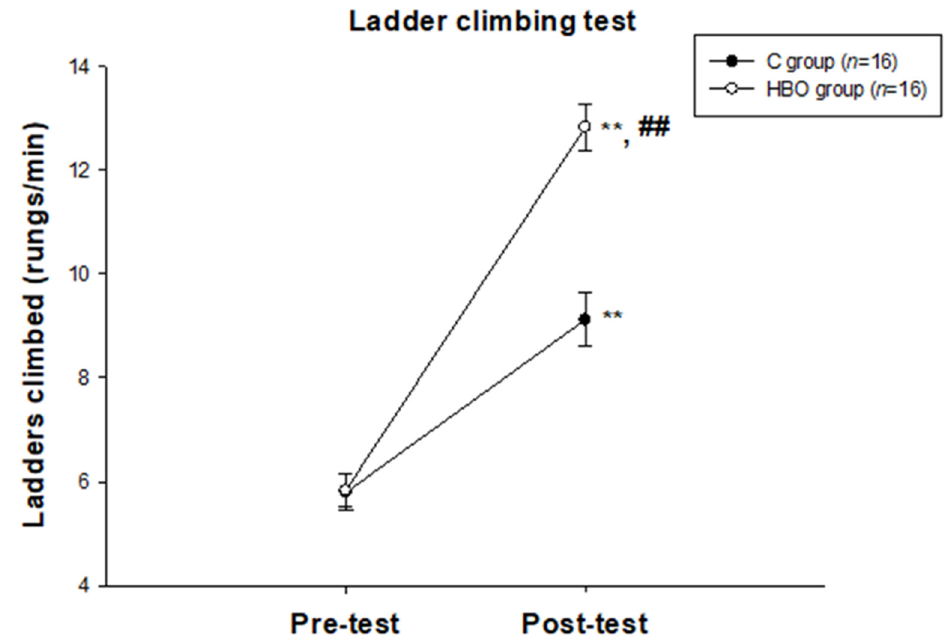
Figure 1. The results of ladder climbing test between groups. **, p < 0.01 compared to the pre-test data. ##, p < 0.01 compared to the C group. C: control; HBO: hyperbaric oxygen.